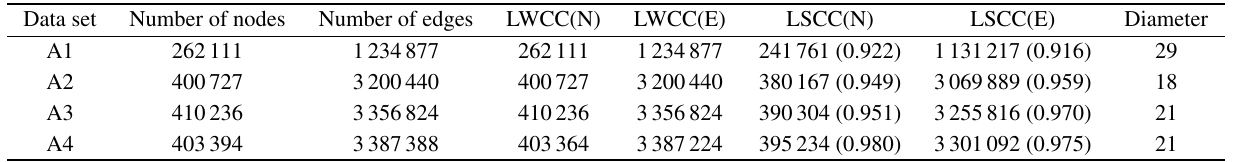
Table 1 Data set 1 in our experiment.